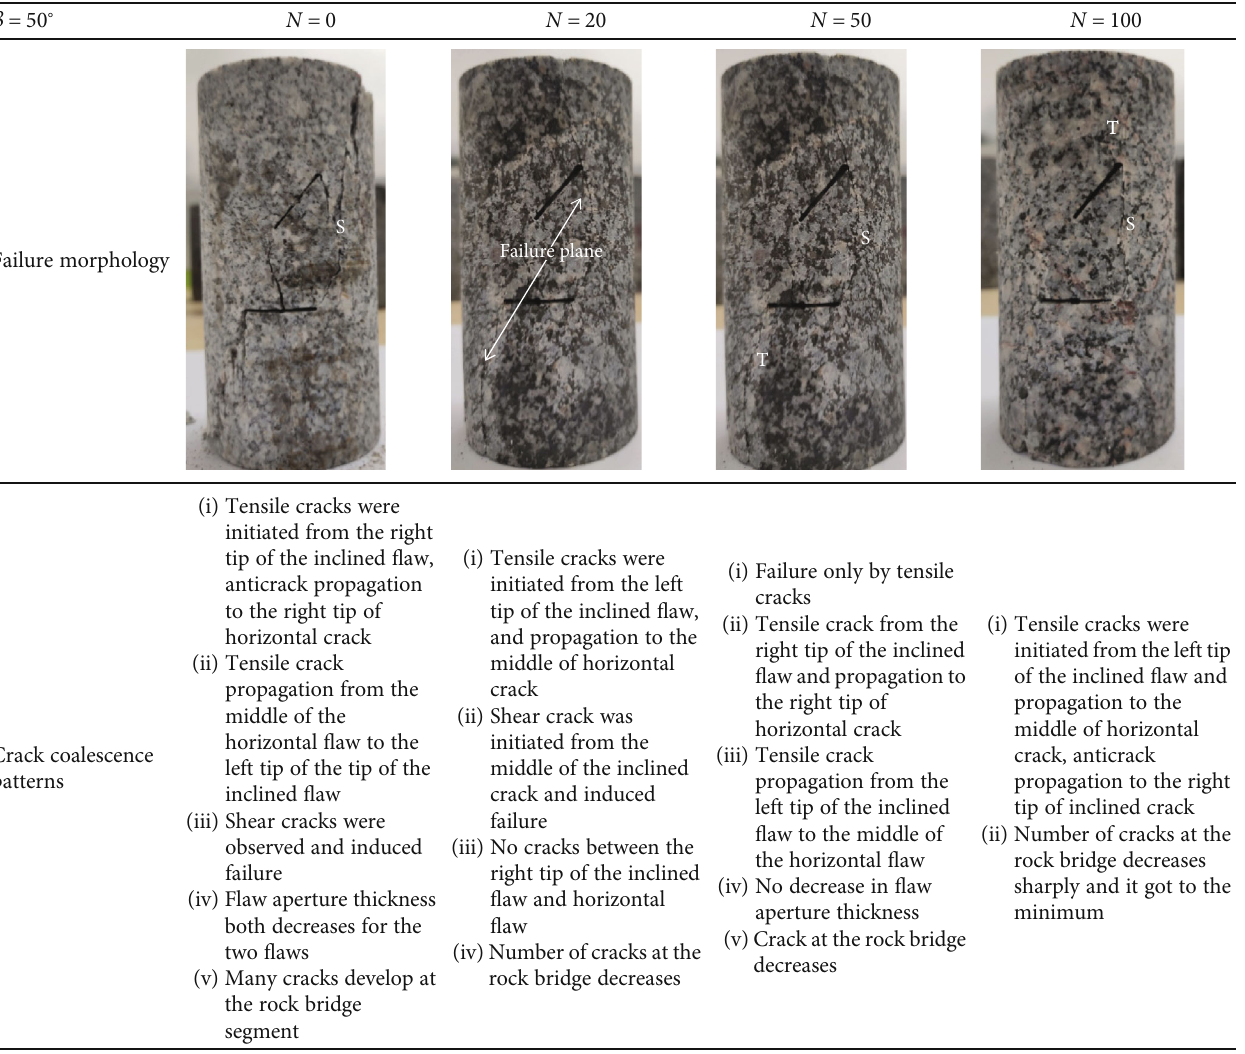
Table 3: Crack propagation and coalescence for the samples with an inclination fl aw of 50 °